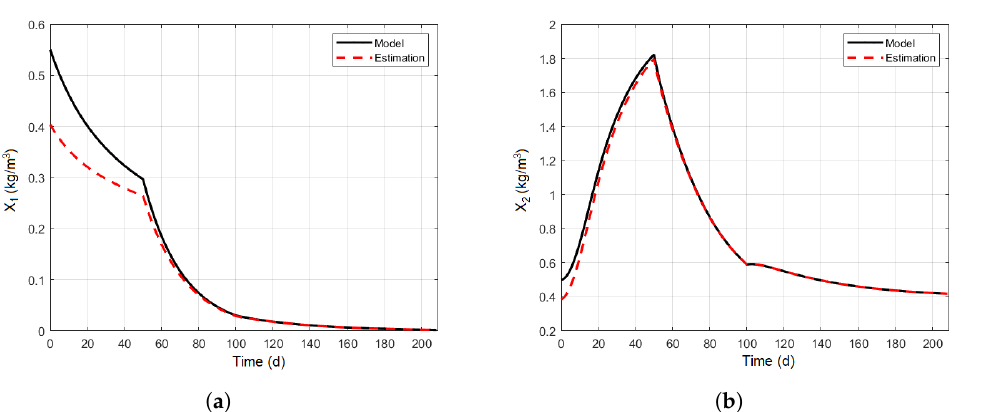
Figure 6. Test for asymptotic observers; a comparison between real and observed state variables. ( a ) Dynamic of state variable X 1 ; ( b ) dynamic of state variable X 2 . Table 2. Evaluation of the adjustments achieved by the parameter identification strategies: genetic algorithm and